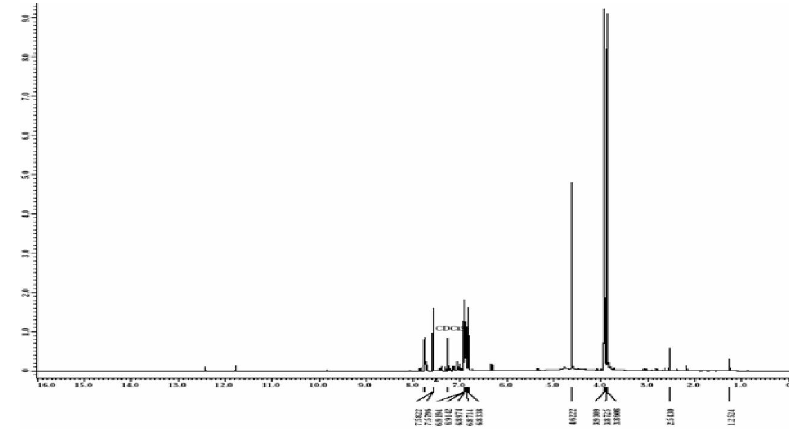
Figure 6. 1 H-NMR spectrum of 2',5'-dihydroxy-3,4-dimethoxy chalcone